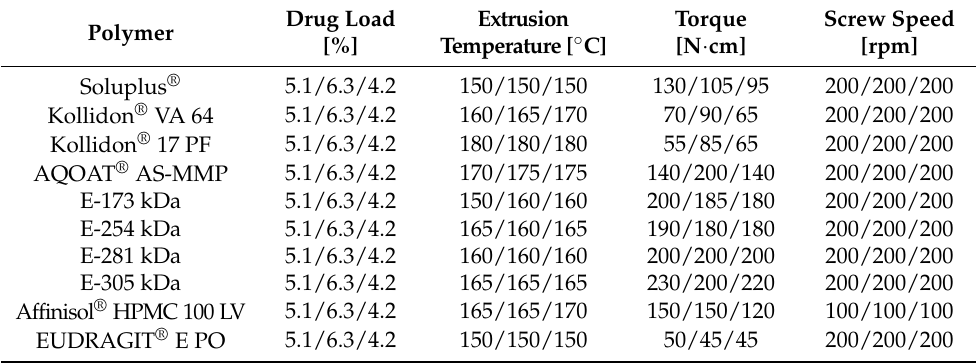
Table 5. Composition and hot melt extrusion process parameters of ASDs incorporating cele- coxib/efavirenz/fenofibrate.